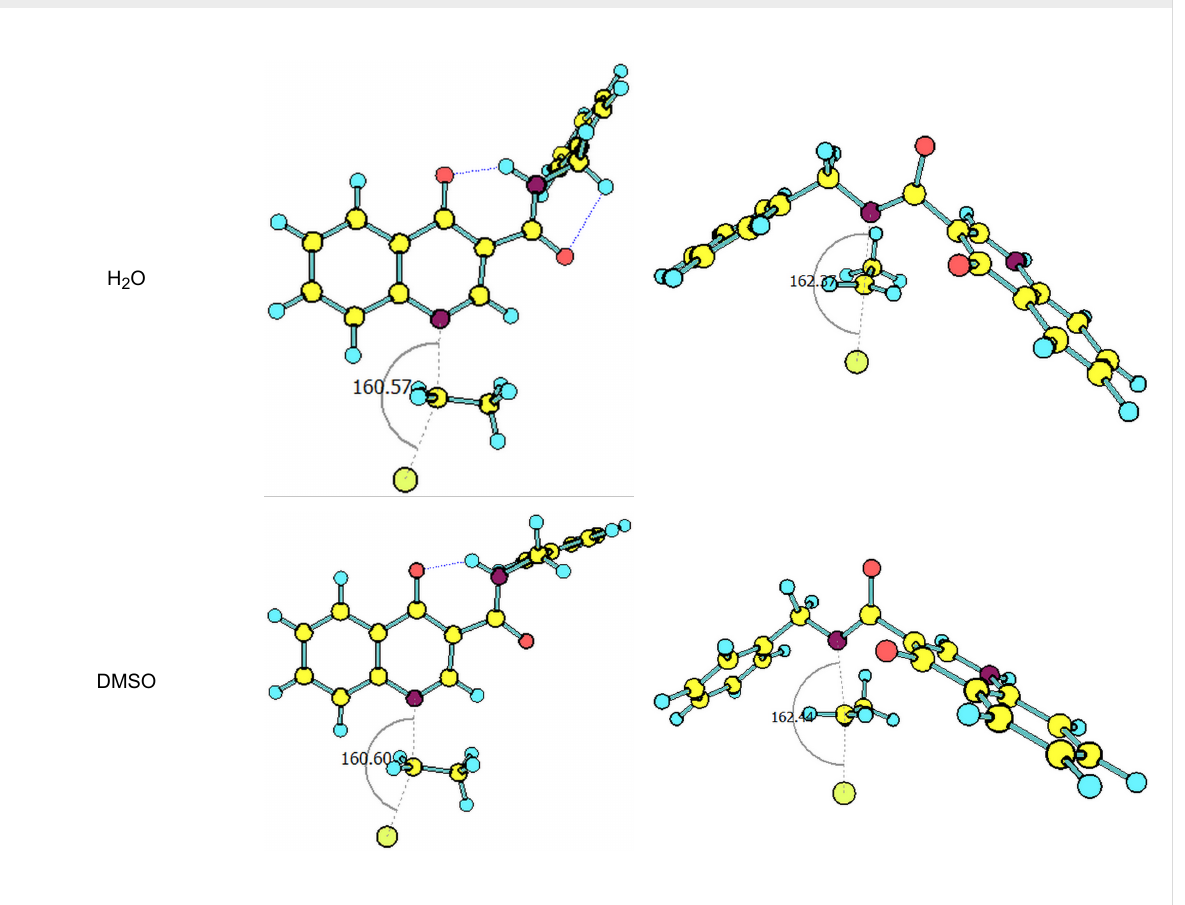
Table 4: Transition states associated with both reaction paths.